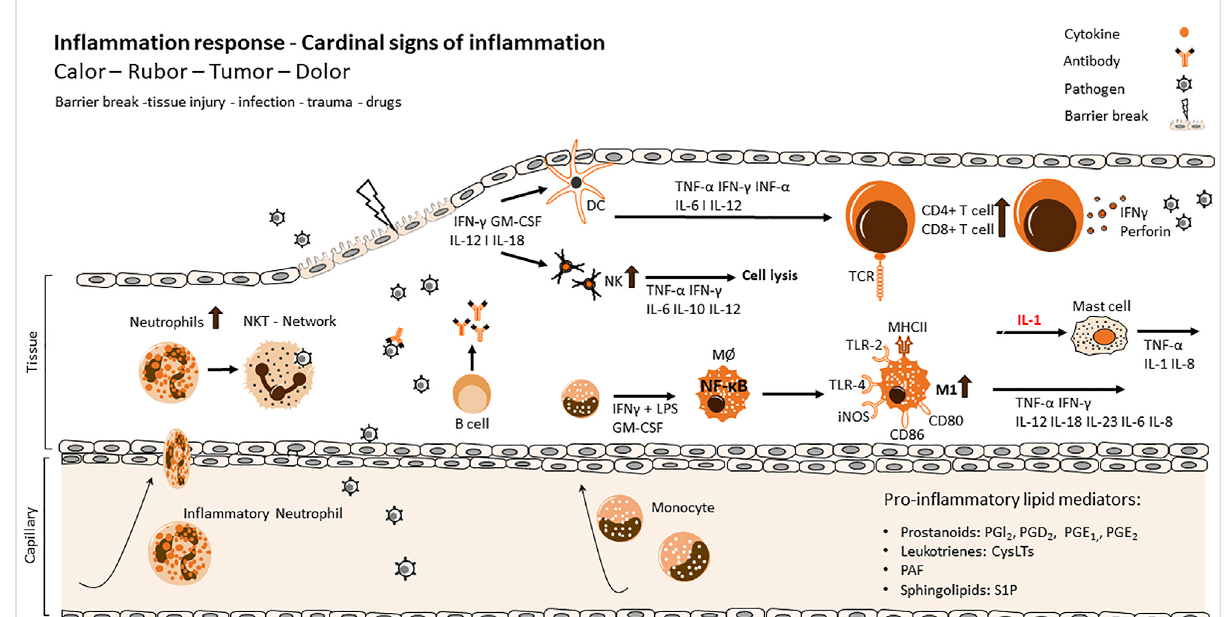
FIGURE 1 Cellular and molecular processes of in fl ammation and resolution via innate and adaptive immune response. Main actors of the different stages of the in fl ammatory process. Tissue injury of the primary immunological barrier is followed by the invasion of pathogens and viruses. In fi ltration initiatesanactivationofhighlycoordinatedreceptorslikeTLRsandCD36atthesurfaceofinnateimmunecellsandtriggerstherecruitmentoffurther immune cells of the innate or adaptive immune system. While the in fl ammatory response evolves, several cellular functions are exerted contemporaneously like the release of toxic substances, phagocytosis, the release of pro-in fl ammatory cytokines and the initiation of antigen recognition via APC cells. Maturated dermal DCs migrate into lymph nodes in order to prime naïve T cells which results in an in fl ux and upregulation ofCD4+/CD8+cellsandproductionofIFN γ andperforinasanadaptiveimmuneresponse.ThematurationofDCsresultsinanupregulationofMHC class II expressing molecules, CD40, CD80, CD86 as well as the production of cytokines like IL12, which activates NK cells to produce IFN- γ and induces the differentiation of Th1 cells. The production of IFN γ and IL2 enhance DC maturation, simultaneously facilitating the clonal expansion of antigen-speci fi c naive T cells, ultimately amplifying the adaptive immune response. IL, interleukin; IFN, interferon; TNF, tumor necrosis factor; TGF, transforming growth factor; Th, helper T cell; Treg, regulatory T cell; TCR, T cell receptor; NF- κ B, nuclear factor kappa-light-chain-enhancer of activated B cell; TLR, toll-like